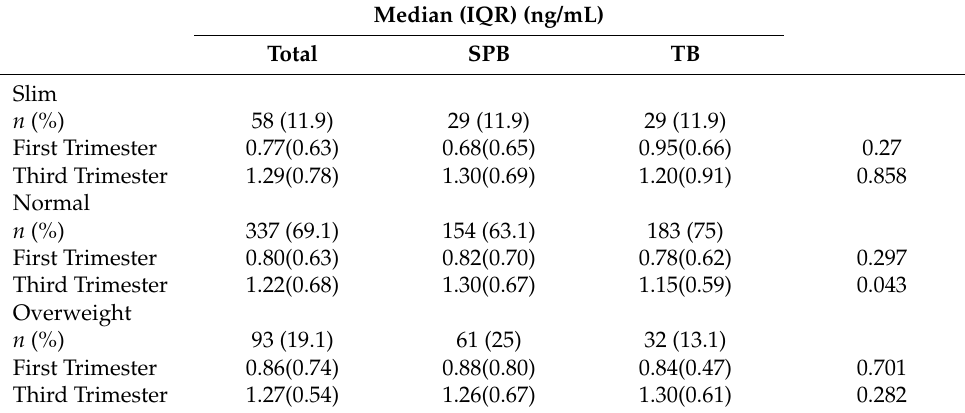
Table 4. Mn concentrations of women who had SPB or term birth stratified by BMI